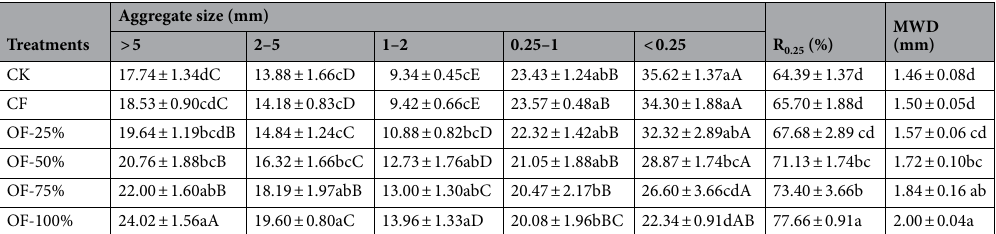
where X i is the mean diameter of aggregates in a sieve fraction (i) in mm, and W i is the proportion of the total sample mass represented by the sieve fraction. For the aggregate fractions from each sieve, we also analysed total organic carbon (TOC) concentrations using the dichromate oxidation method with external heating 35 . Moreover, to measure permanganate oxidizable carbon (POC) concentrations in the aggregate fractions, we used the permanganate oxidation method with oxidation by 333 mmol L −1 KMnO 4 measured with a spectrophotometer at 565 nm 36 . The contribution rate of aggregates to organic carbon (CAOC) was calculated according to the formula of Li et al. (2014) 37 .